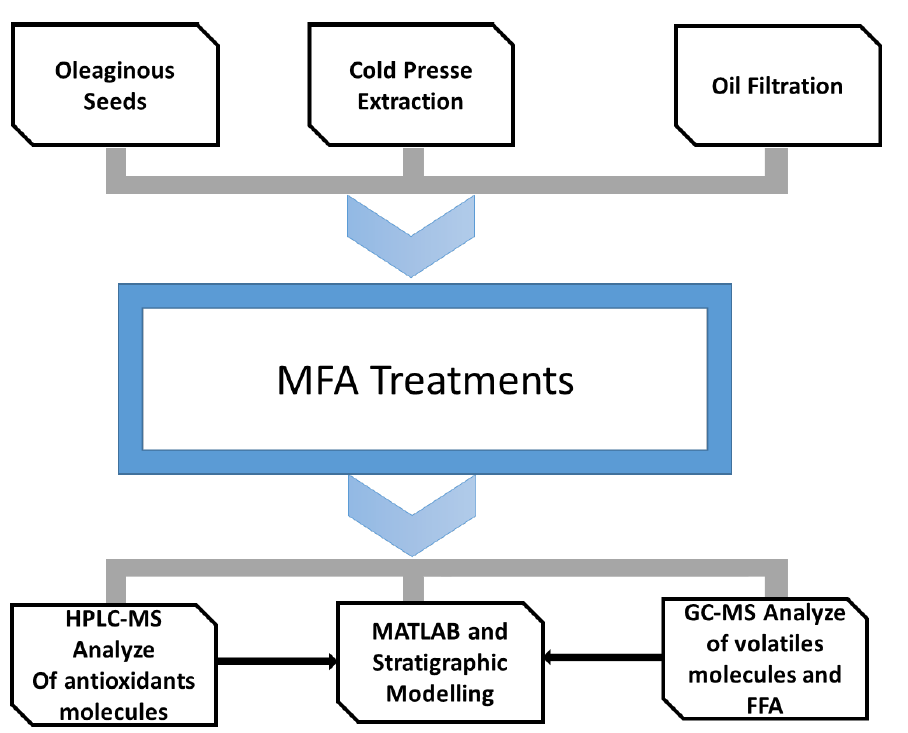
Figure 1. Schematic diagram of experimental study of palm oil deodorization by MFA (Multi-Flash Autovaporization).